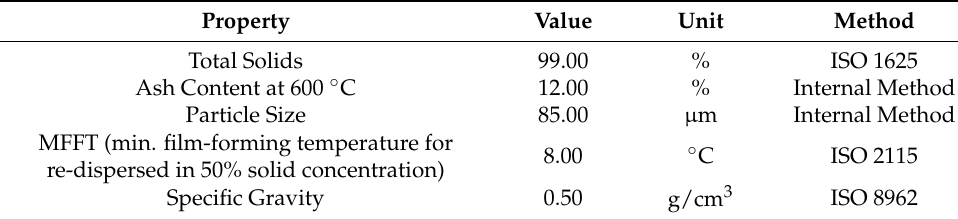
Table 2. Chemical Properties of SBR